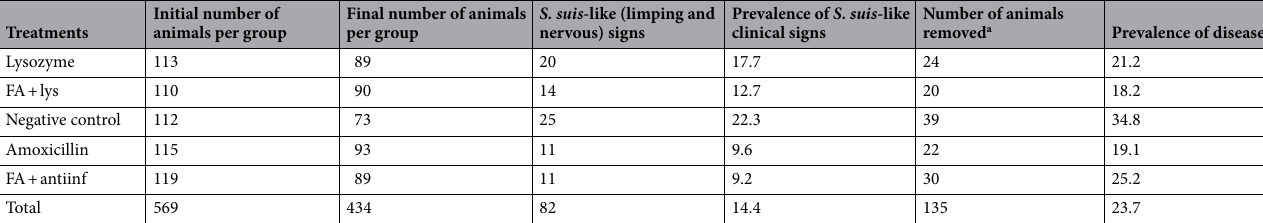
Table 1. Number of animals that needed to be removed from each of the treatment groups including clinical signs compatible with infection caused by S. suis , and prevalence of disease in each treatment group. a Includes clinical sings compatible with S. suis (limping and nervous signs), coughing, wasting and